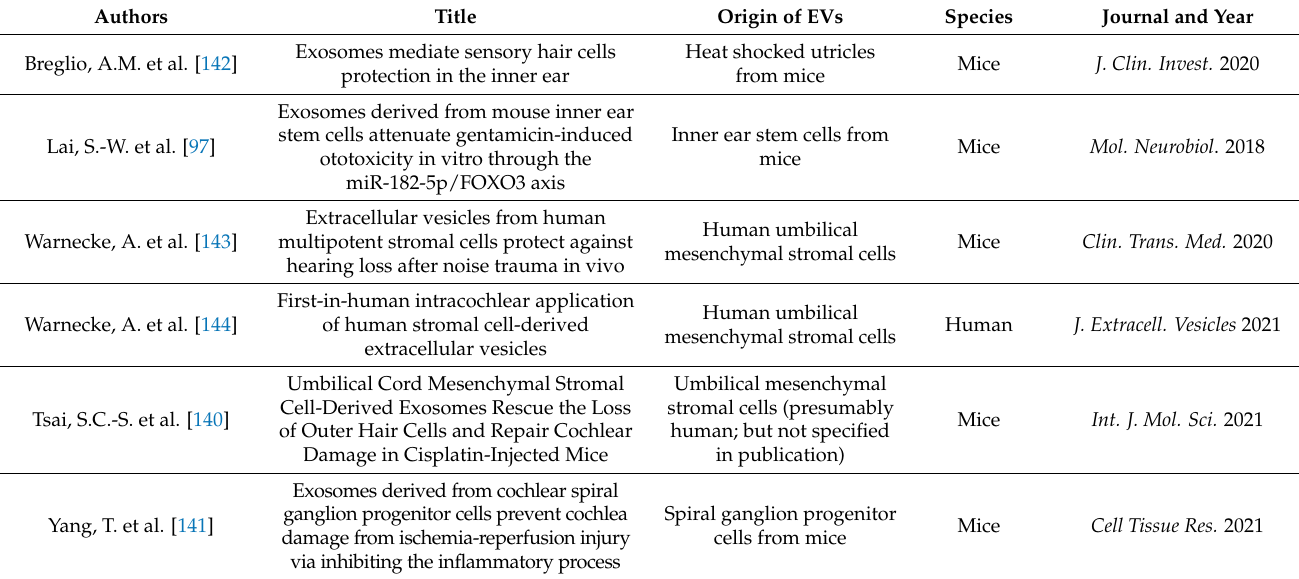
Table 1. Summary of the studies demonstrating inner ear protection by